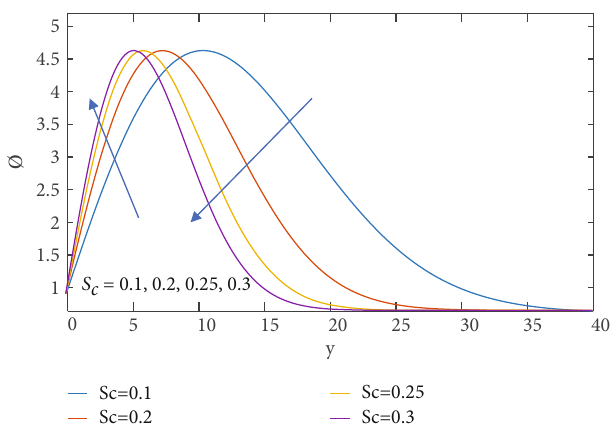
Figure 8: Distinct values of Sc for concentration fi eld when Ec = 0 : 1 , t = 0 : 2 , and Kc = 1 .